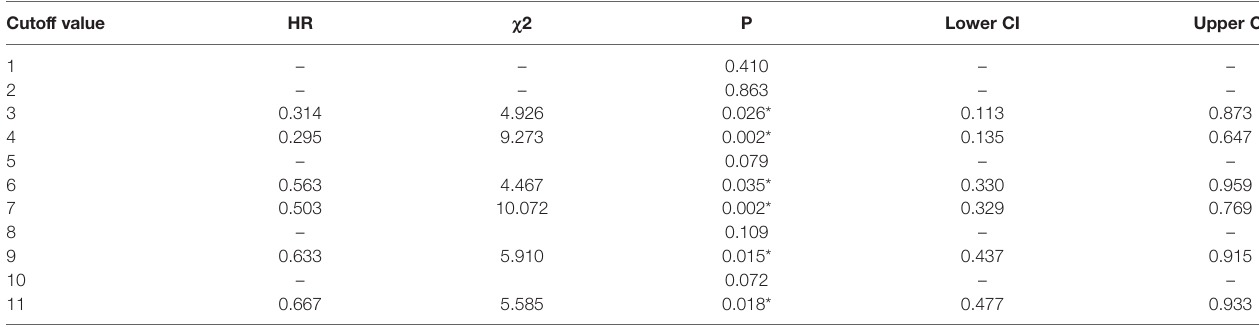
TABLE 4 | Cut-point survival analysis of each dissected lymph node. Cutoff